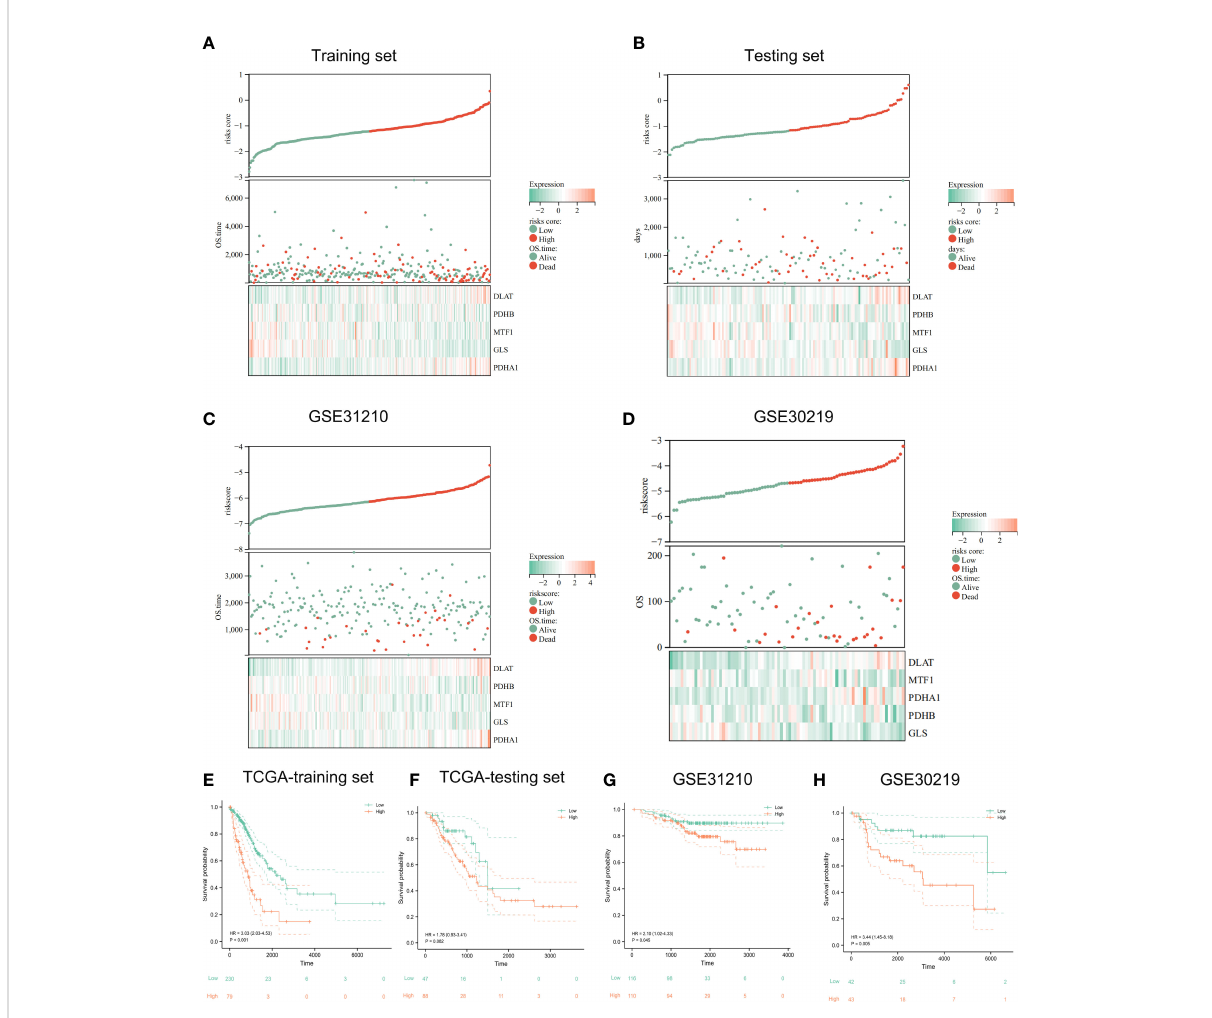
FIGURE 5 Evaluation and validation of prognostic signature. The risk-score, survival time, survival status and gene expression of the training set (A) , testing set (B) , and external set GSE31210 (C) and GSE30219 (D) . Kaplan-Meier analysis demonstrated the prognostic signi fi cance of the risk model in TCGA training set (E) , testing set (F) and GSE31210 (G) , GSE30219 cohort (H)